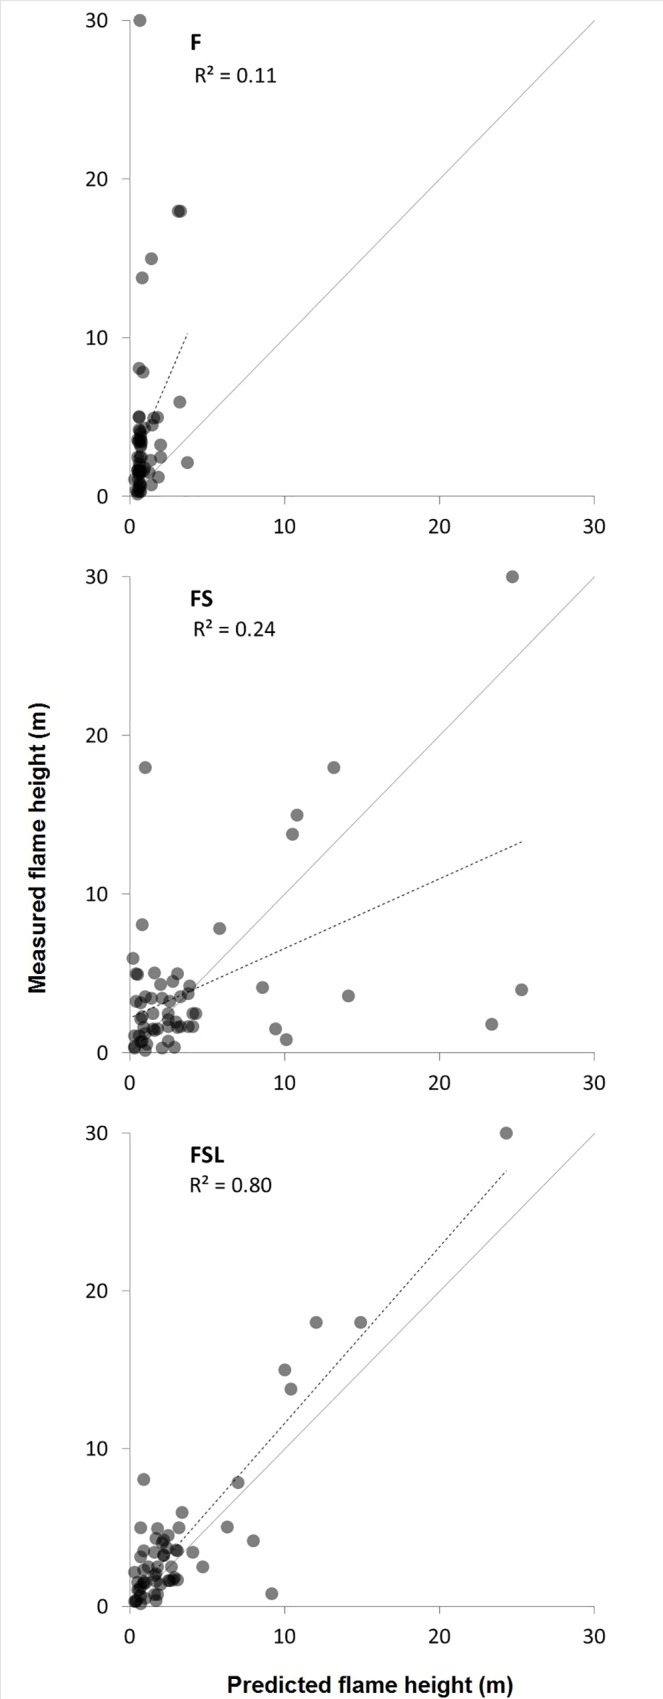
Median estimated vs. predicted flame height for the three treatments.Using surface fuel only (F), all predictions were for low flame heights (R2 = 0.11). Including structure with that fuel (FS) enabled the prediction of large flames, but the accuracy was low (R2 = 0.24). The inclusion of leaf traits (FSL) significantly improved the accuracy of predictions (R2 = 0.80), producing a MAE 3.80 times smaller than F, (p < 0.01, paired t-test), and 4.67 times smaller than FS (p < 0.01). The line of exact agreement is shown as solid, and the trend of the data is shown as a broken line, with R2 reported under the treatment name.